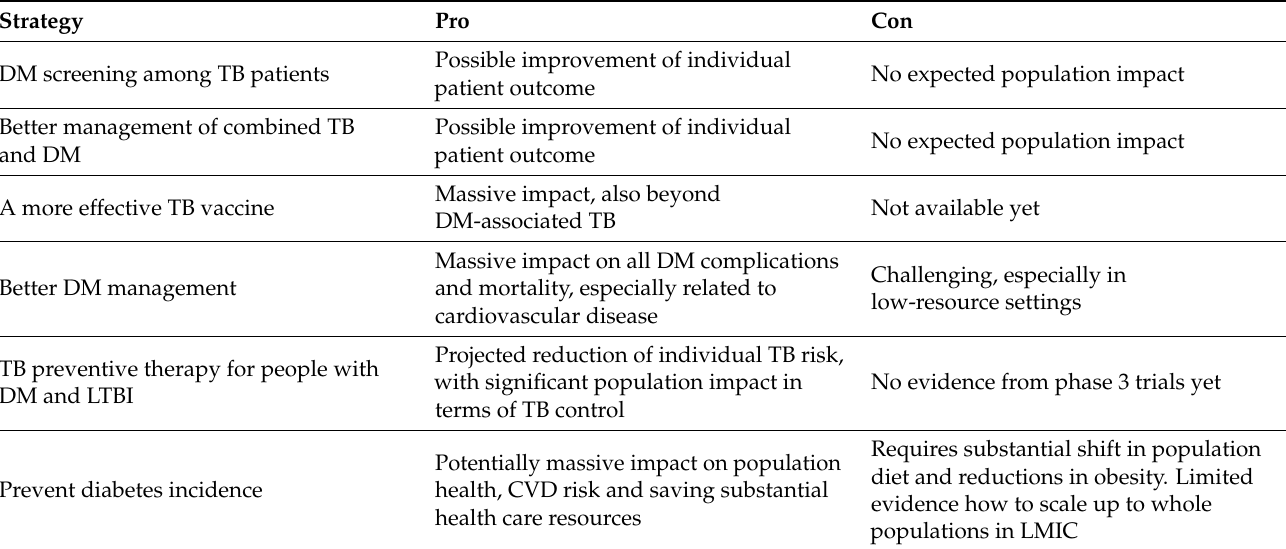
Table 3. Potential Strategies for Control of Diabetes-Associated